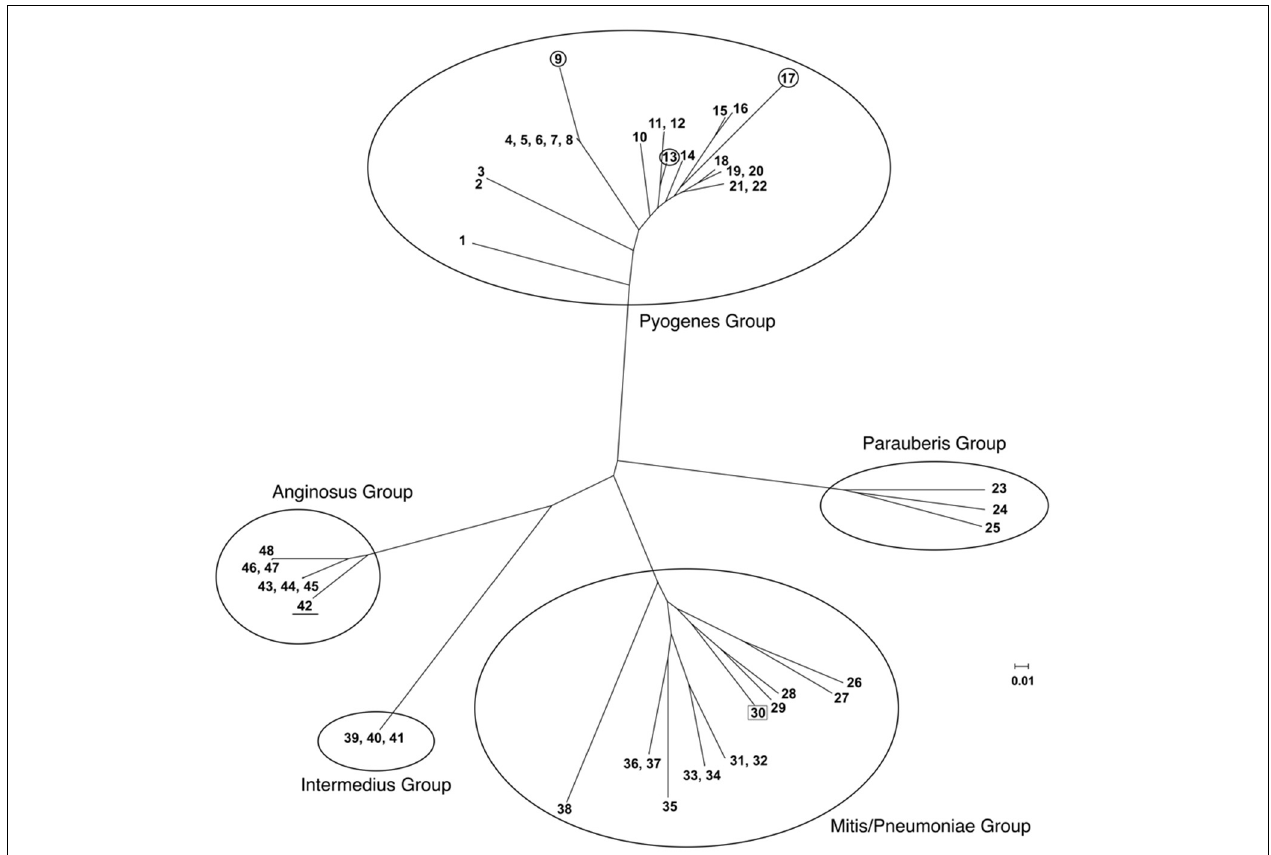
FIGURE 4 | Phylogenetic tree of streptococcal chromosomal islands integrated into DNA repair genes mutL. Full genome trees are derived. In the Pyogenes group, all of which integrate into mutL , the circled members of the tree are CI found in the closely related species S. dysgalactiae subsp. equisimilis (SeqCI; nos. 9 and 13) and S. canis (ScaCI; no. 17). The SmiCI that integrates into manA in the Mitis/Pneumoniae group is boxed for identification; the remainder of the